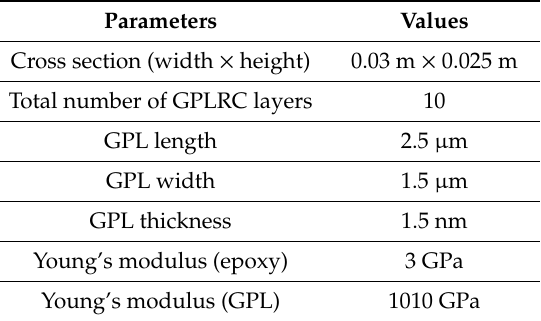
Table 1. Material properties of the FG-GPLRC